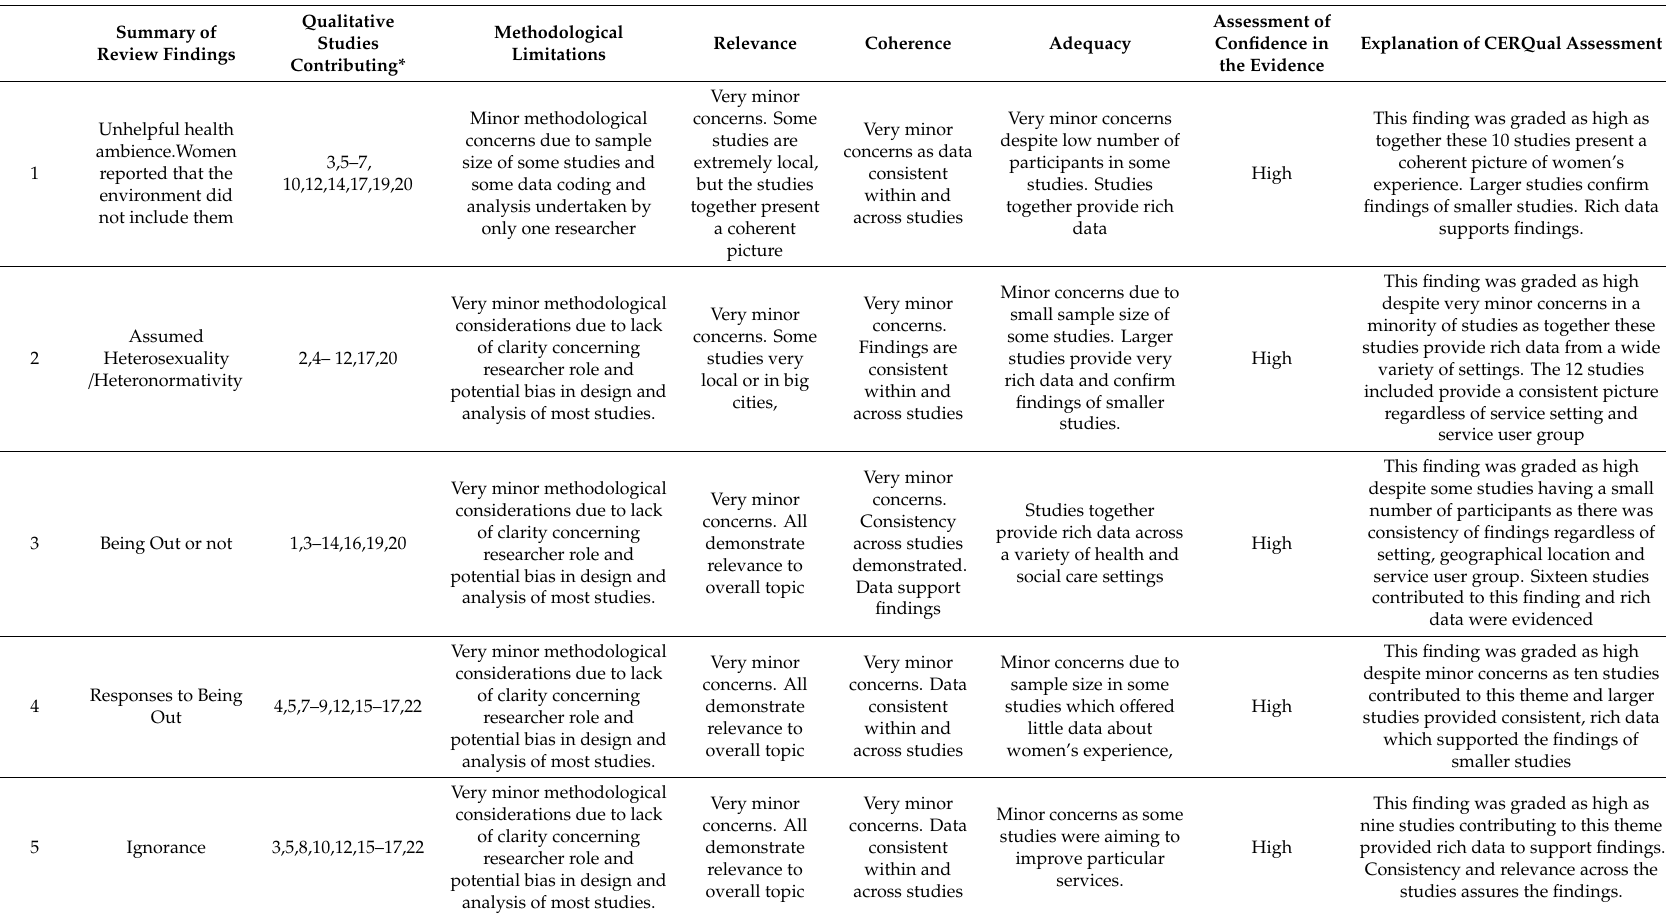
Table 5. CERQual qualitative evidence